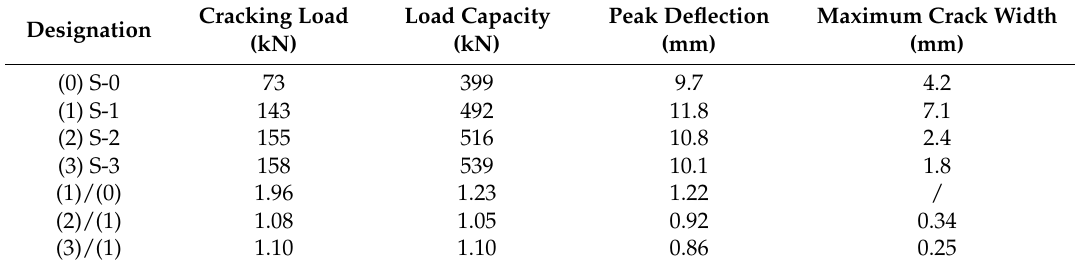
Table 2. Summary of compressive test results of the four